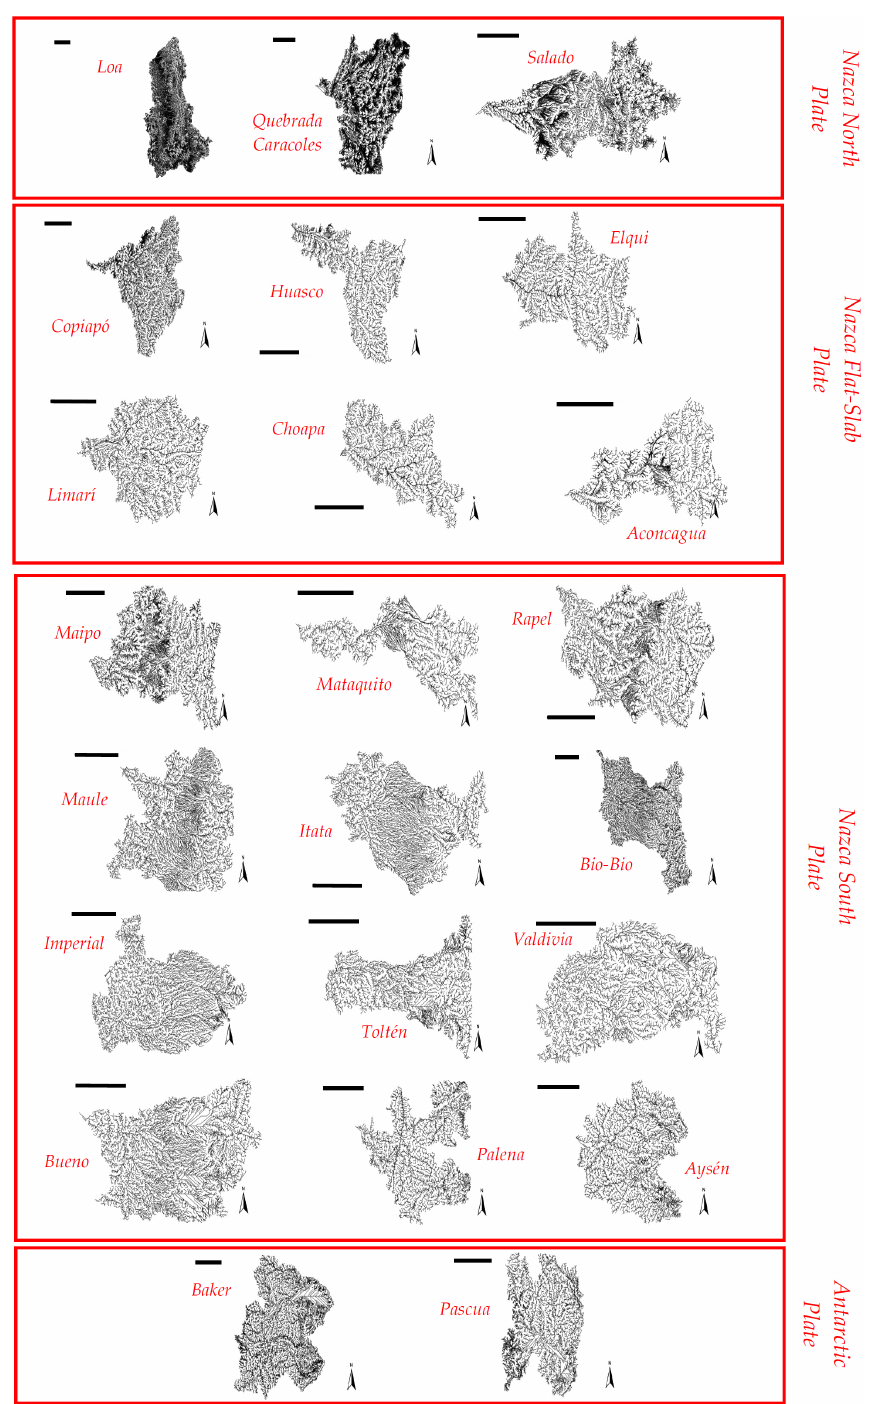
Figure 2. River networks of large networks obtained from GRASS-GIS, sorted by tectonic-segment influence. The size of every image is proportional to the area of the network (scale 1:50,000). The length of black bars represents 50 km in each